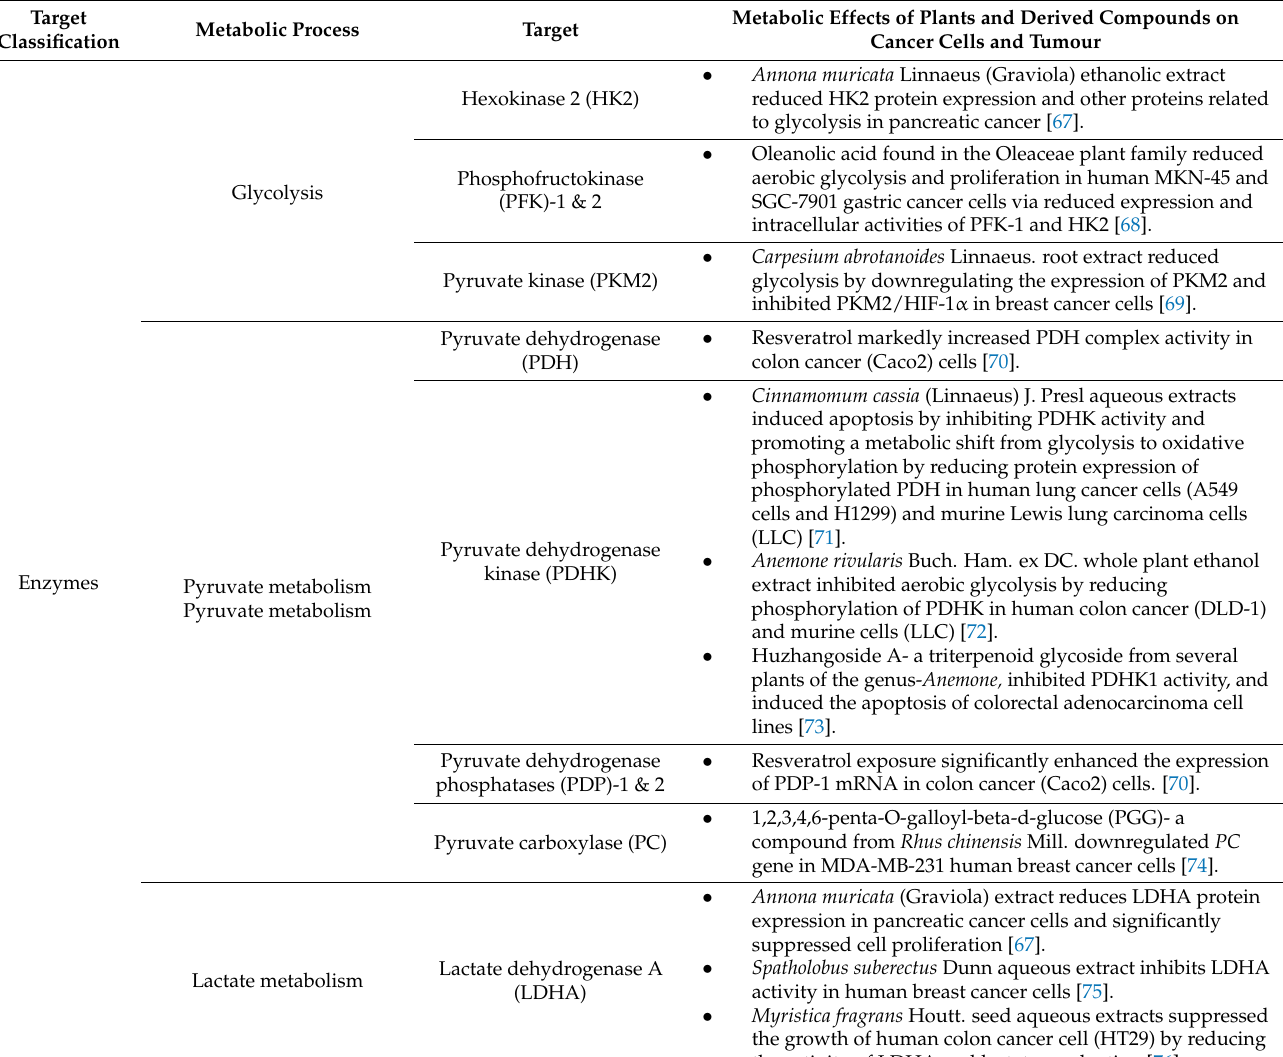
Table 3. Modulatory effects of medicinal plants on cancer